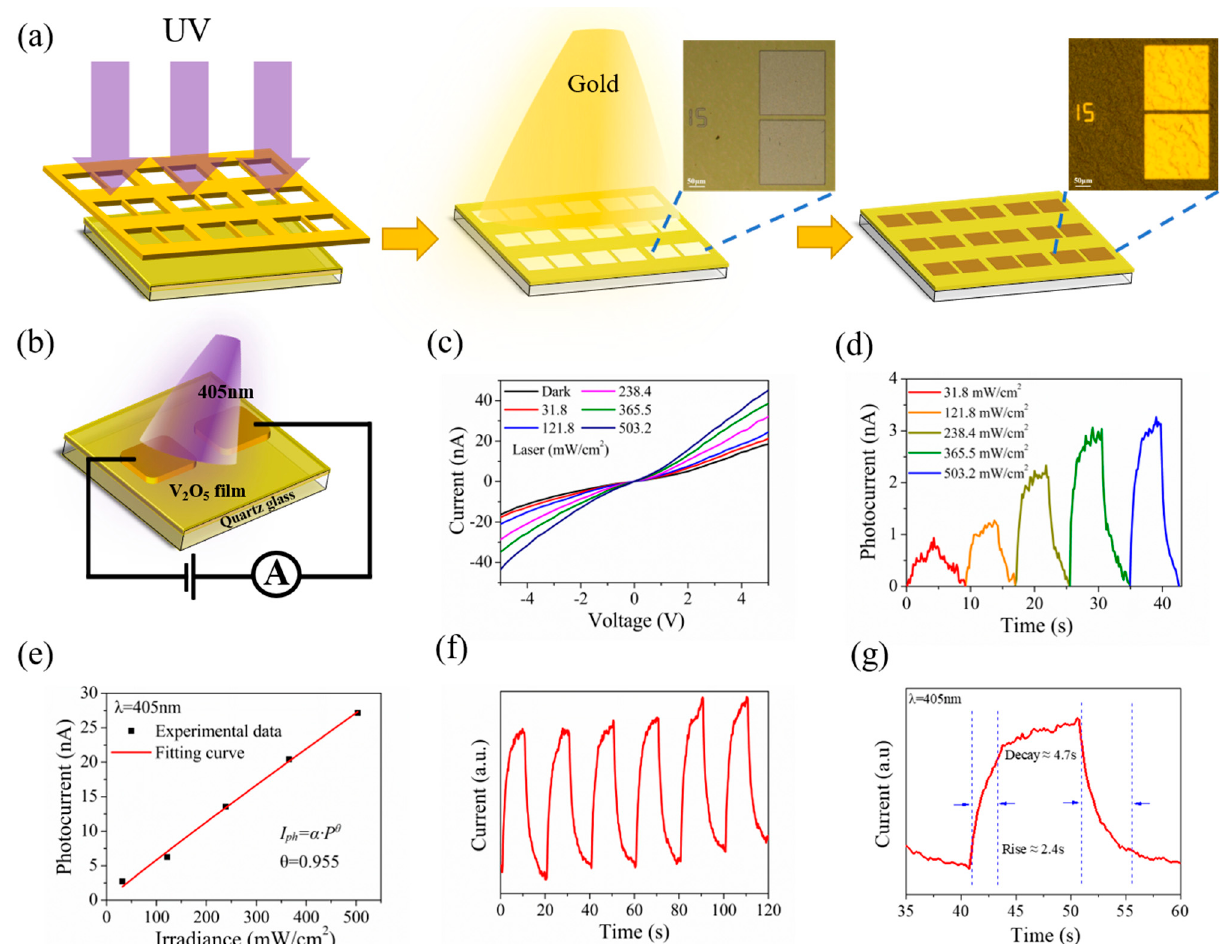
Figure 5. ( a ) Schematic diagram of electrode deposition on V 2 O 5 film. Inset: The optical image. ( b ) Schematic of the V 2 O 5 nanosheets film-based photodetector. ( c ) I − V curves of the device in the dark and under illumination with different intensities. ( d ) Light intensity − dependent photoresponse at V bias = 1 V. ( e ) Photocurrent as a function of laser power intensity. ( f ) Time − resolved photoresponse of the device recorded for a power density of 503.2 mW cm − 2 . ( g ) Response rate of photodetector acquired from one magnified circle of response with rising time 2.4 s and decay time 4.7